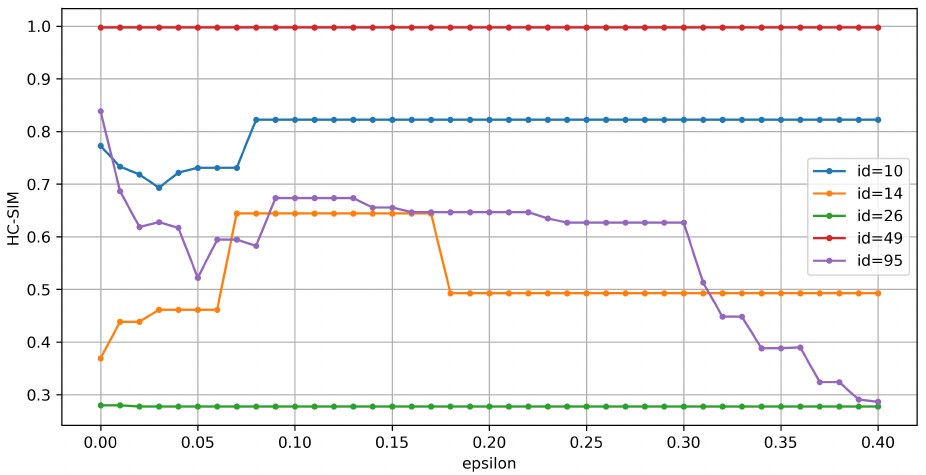
Figure 5. HC-SIM of single samples as function of DP (cid:101)